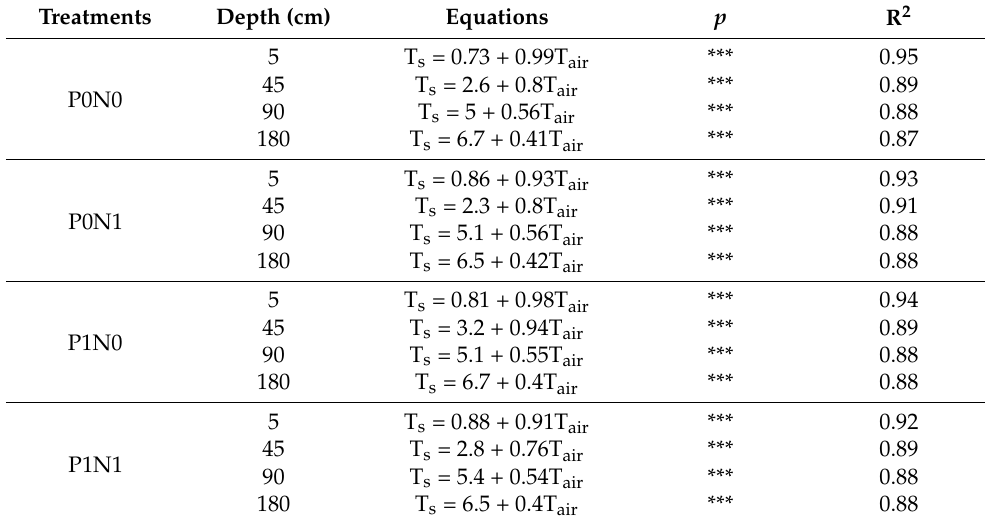
Table 7. Relationship between annual mean air and soil temperatures at different soil depths.